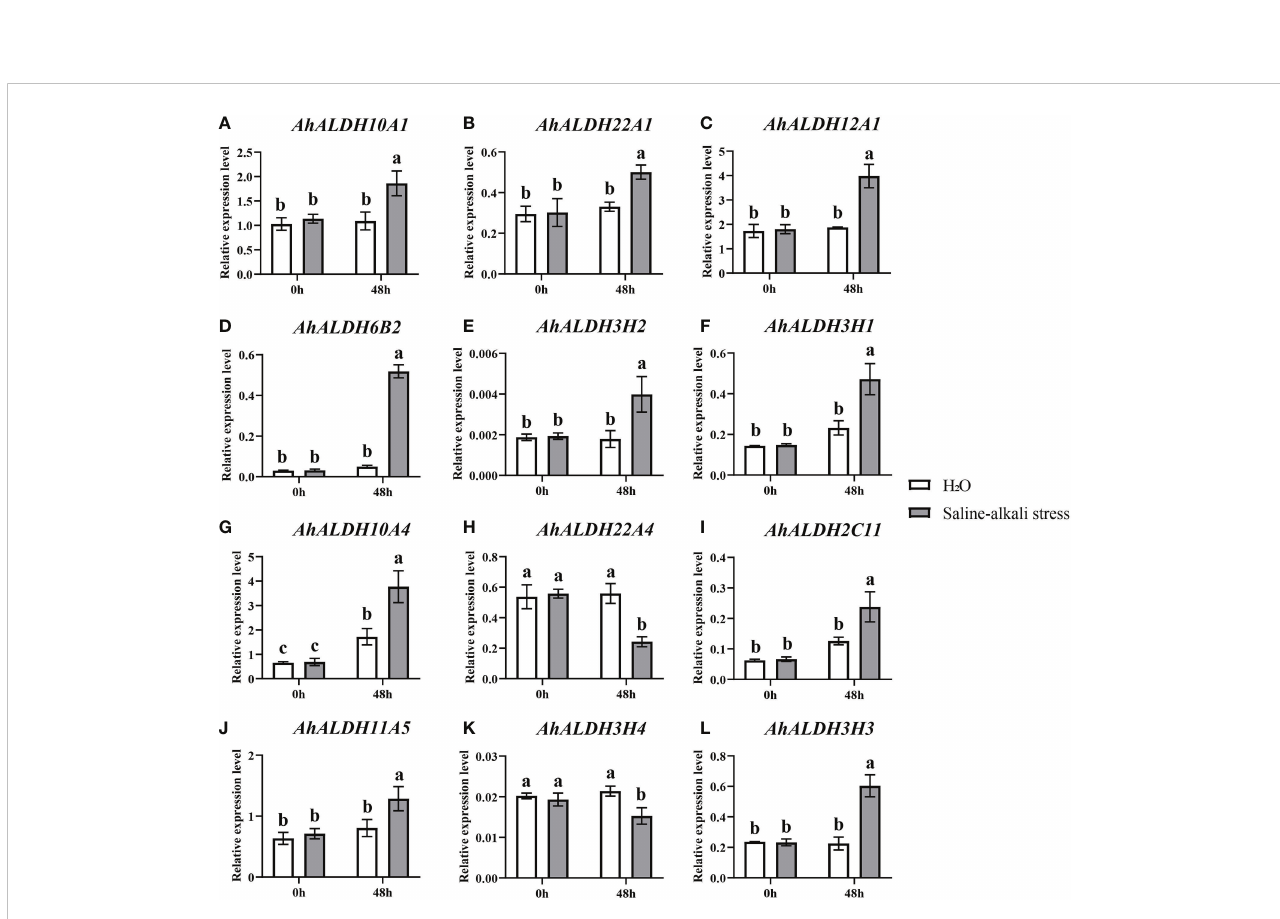
FIGURE 10 Expression pattern analysis of 12 AhALDHs under saline-alkali stress at 0h and 48h. White columns show the expression in the H 2 O at the sprout stage, while gray columns show the expression in the saline-alkali stress treatment. (A – L) The expression analysis of 12 AhALDH